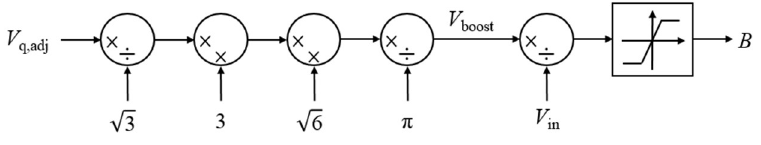
Figure 9. Boost control unit of the PI-based BC.